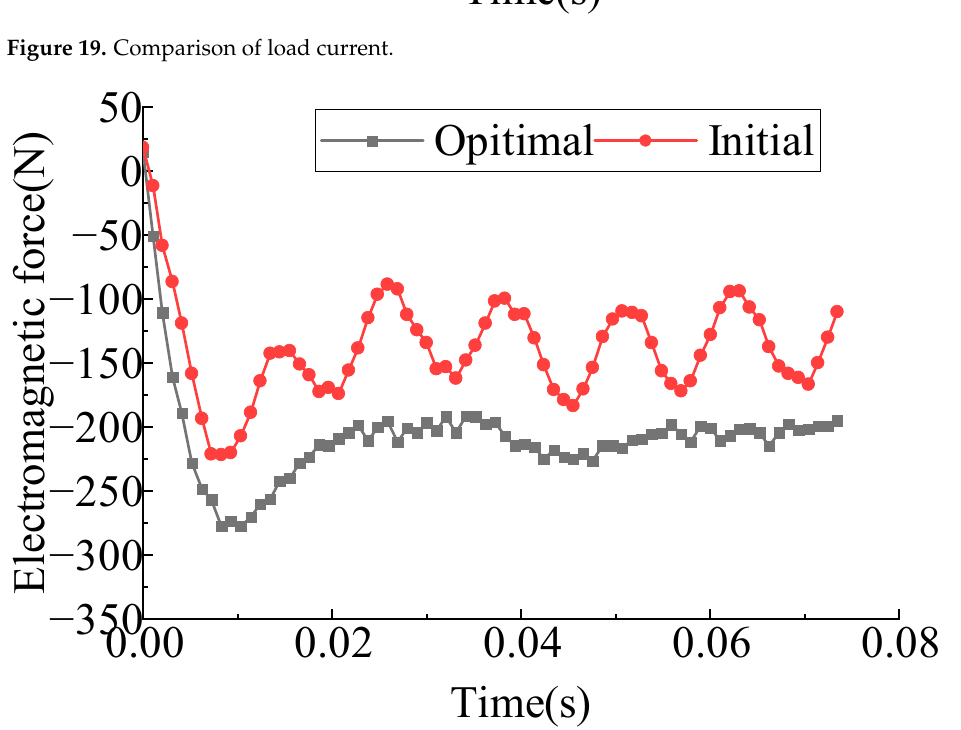
Figure 20. Comparison of electromagnetic force.